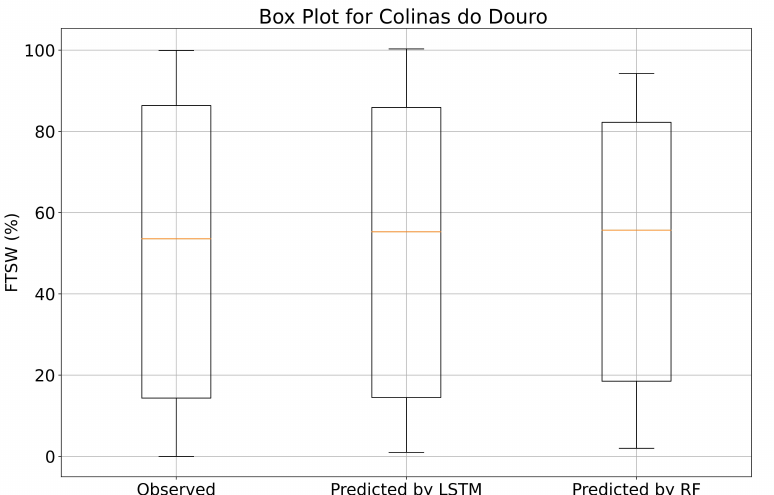
Figure 14. Boxplots showing the dispersion of the observed and predicted FTSW during the testing phase for the RF and BiLSTM models. The box shows the interquartile range (25–75th from the 5th to 95th percentile). The solid line within the box indicates the